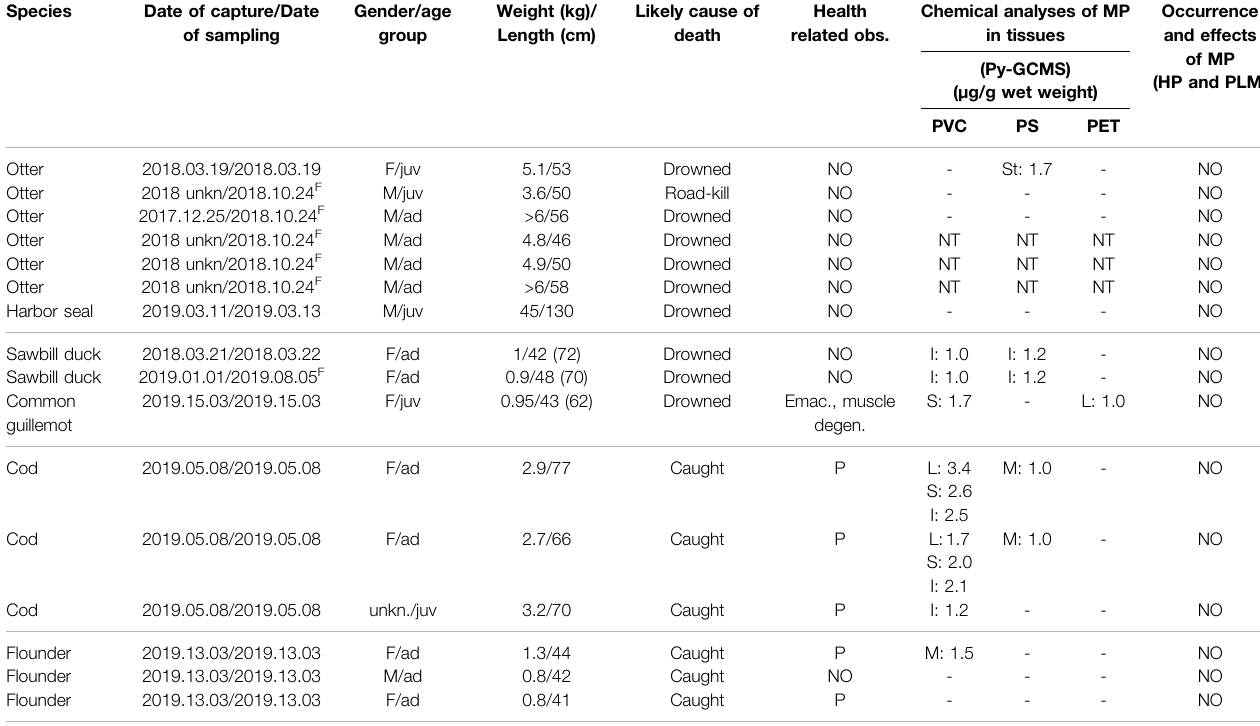
TABLE 1 | Details of the sampled animals, results of the autopsies, general health, histopathological observations and chemical analyses of MP in tissues from wildlife from Sotra 2018 – 2019.